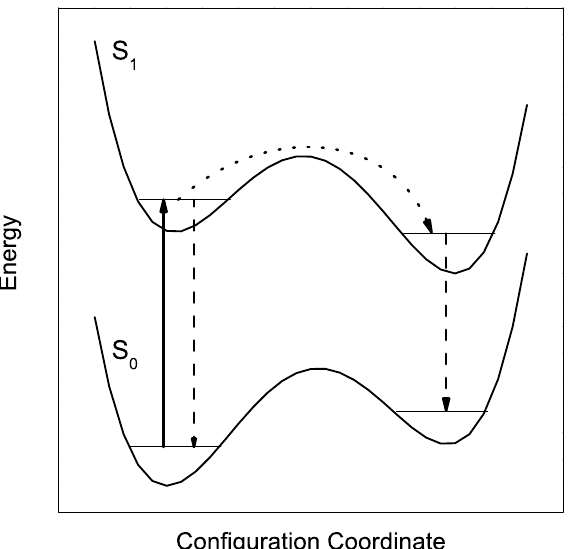
Figure 2. Model potential of the phthalocyanine solvation complex explaining dual emission (dashed vertical arrows) upon electronic excitation (full vertical arrow) by partial relaxation (dotted curved arrow) of the configuration of the solvation